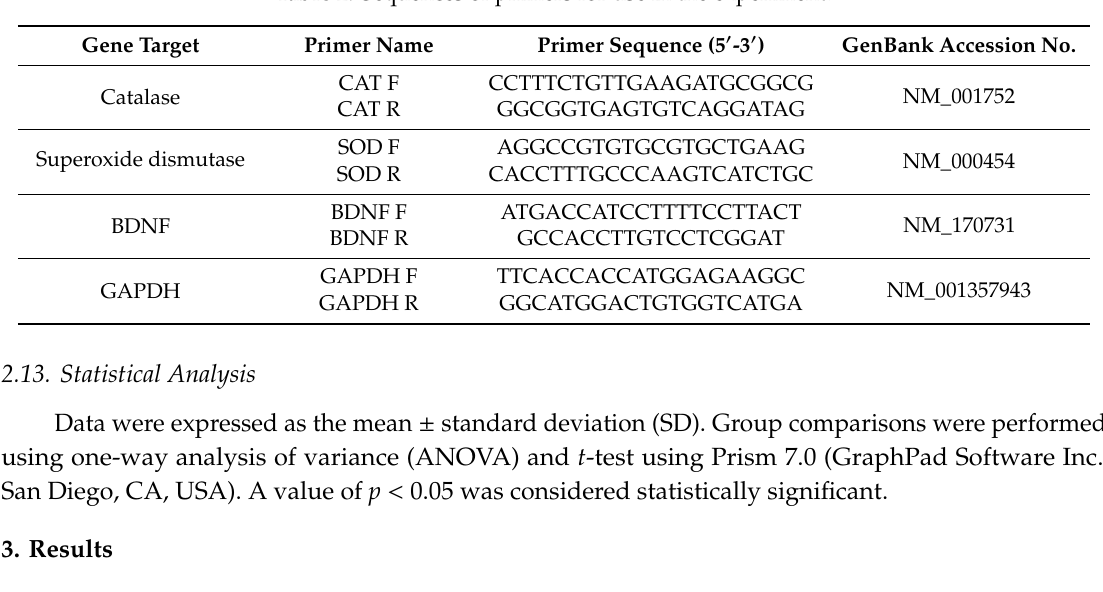
Table 2. Sequences of primers for use in the